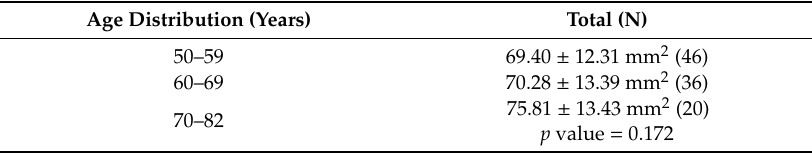
Table 2. The age distribution of patients with the mean IAPCSA in the control group.